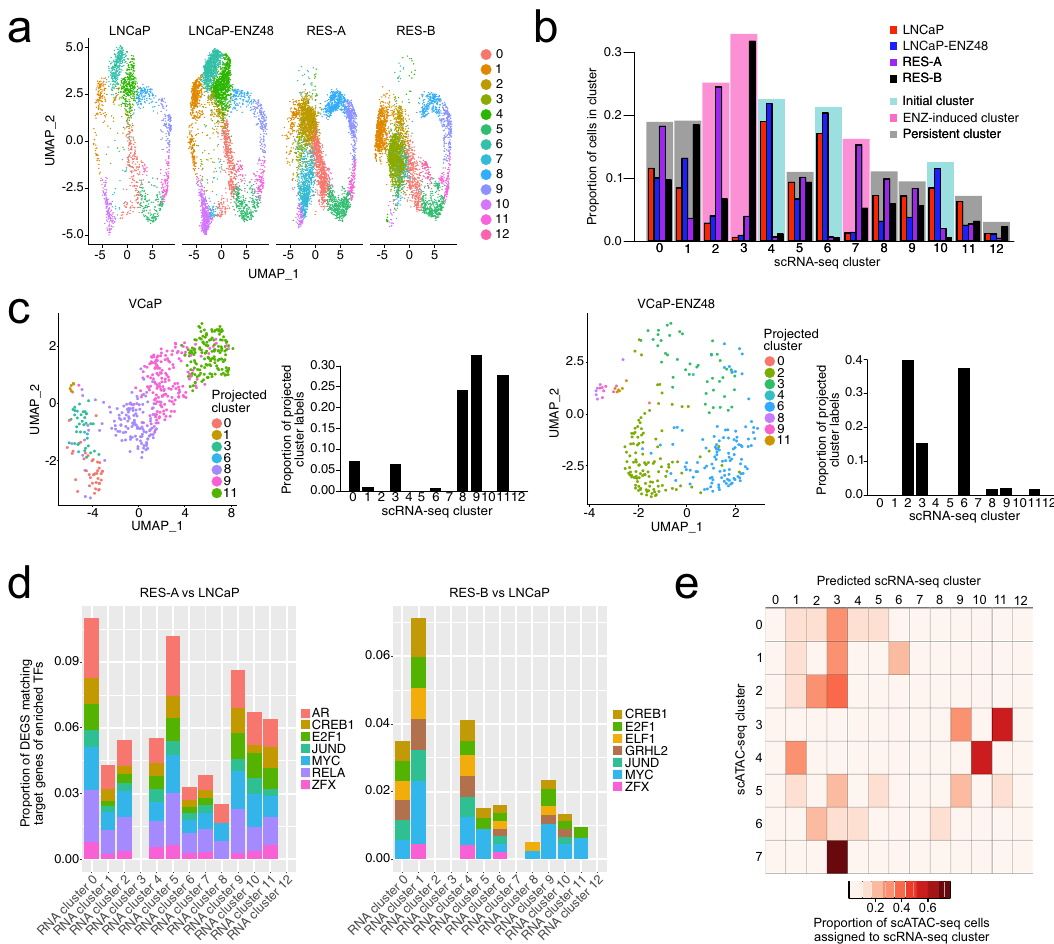
Fig. 3 Chromatin states of enzalutamide resistance can result in multiple transcriptional programs. a Uniform manifold approximation and projection (UMAP) clustering visualization of single-cell RNA sequencing (scRNA-seq) of LNCaP parental, LNCaP – ENZ48, RES-A, and RES-B. b Proportions of cells in clusters identi fi ed from scRNA-seq. Clusters are colored according to cluster type: initial (most prevalent in LNCaP parental and LNCaP – ENZ48), ENZ- induced (most prevalent in RES-A or RES-B), or persistent (present in similar proportions in all samples). c Cluster-label transfer from the integrated clustering of the LNCaP scRNA-seq data to VCaP parental (left) and VCaP treated with enzalutamide for 48 h (right), con fi rming the presence of these cell states in the alternate model. In the UMAP, each cell is colored according to the LNCaP scRNA-seq cluster that it is predicted to belong to. The barplot shows the proportion of the projected cluster labels for each scRNA-seq cluster. d Proportion of differentially expressed genes (DEGs) in each LNCaP scRNA-seq cluster for the indicated sample comparisons that is composed of enriched transcription-factor (TF) target genes. The contributions of enriched TFs identi fi ed in the scATAC-seq are shown as a stacked barplot. e Identi fi cation of matching cell clusters between the scRNA- and scATAC-seq data from LNCaP visualized as heatmap. The heatmap shows the proportions of cells from each scATAC-seq cluster across all sample conditions assigned to each scRNA-seq cluster as part of the label-transfer process. The proportions were calculated for each scATAC-seq cluster, with the total as the number of cells from the scATAC-seq that could be con fi dently assigned to a scRNA-seq cluster (con fi dence score > 0.3). ENZ = enzalutamide. See also Supplementary Fig.